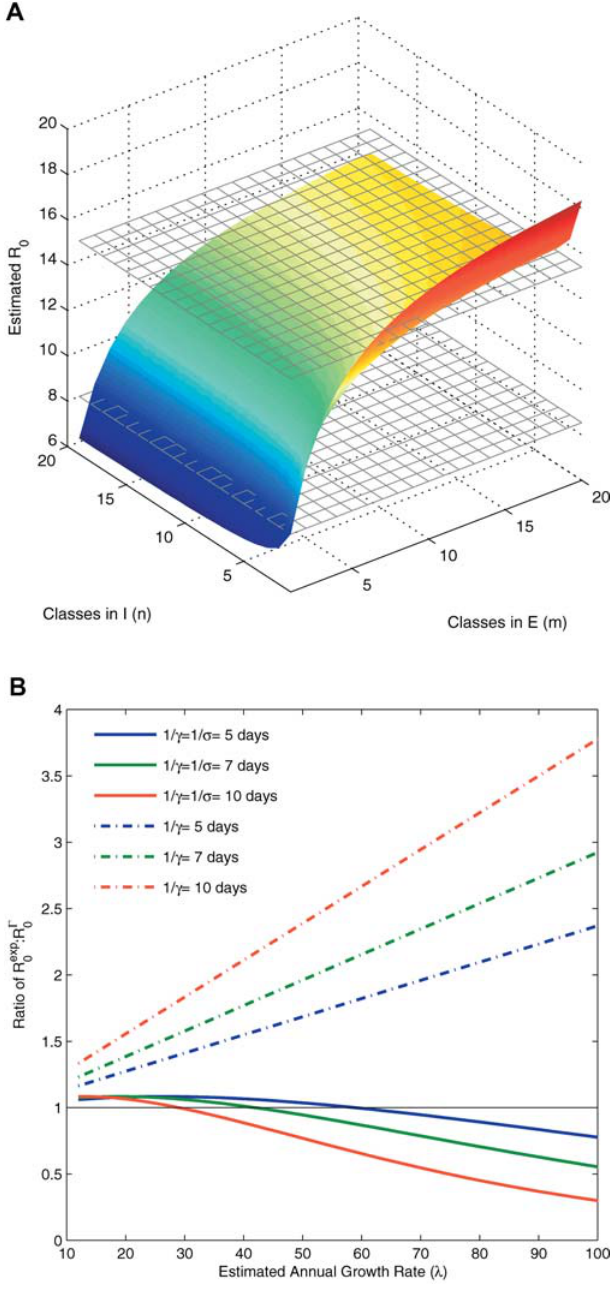
Figure 2. Estimates of R 0 from Data on the Initial Growth Rate of an Epidemic (A) The effects of changing the distributions of the latent and infectious periods on the estimated value of R 0 , with k assumed to be 100 per year and the average latent and infectious periods fixed at 1 wk. The gray grid surfaces show the asymptotic values of R 0 when the latent and infectious periods are both exponentially distributed (lower surface) or fixed (higher surface). We note that the shape of each surface is independent of the exact value of k . (B) At higher values of k , R 0 may be substantially over- or underestimated using the classical exponentially distributed model (n ¼ m ¼ 1) compared to periods of fixed lengths (n ¼ m ! ‘ ), depending on whether an exposed class is included (solid lines) or not (dashed lines). DOI: 10.1371/journal.pmed.0020174.g002